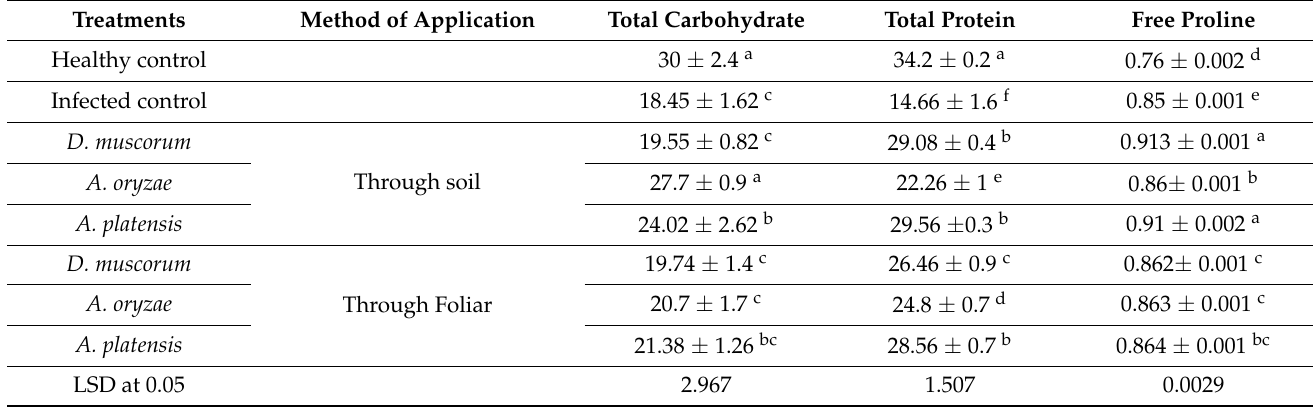
Table 2. Effect of cyanobacteria on osmolytes (soluble sugar, soluble protein, and proline) mg g − 1 DW) contents of the infected pepper plant with Fusarium wilt. Data presented as means ± SD (n = 3). Data followed by letters are significantly different in the LSD test at p ≤ 0.05.